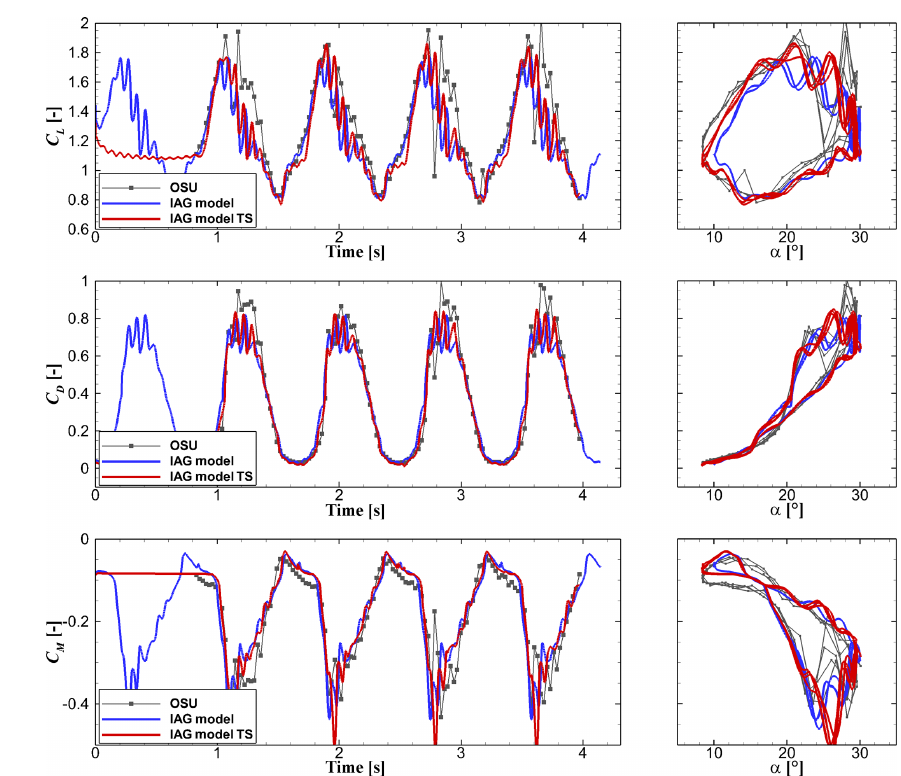
Figure 11. Dynamic force reconstruction by the IAG model in comparison with the measurement data (Ramsay et al., 1996) for (cid:49)t = T/ 1440 using the actual angle of attack in the experimental campaign. TS labels the exact time signals in the experimental campaign. S801 airfoil, k = 0 . 073, α = 20 ◦ and (cid:49)α = 10 ◦